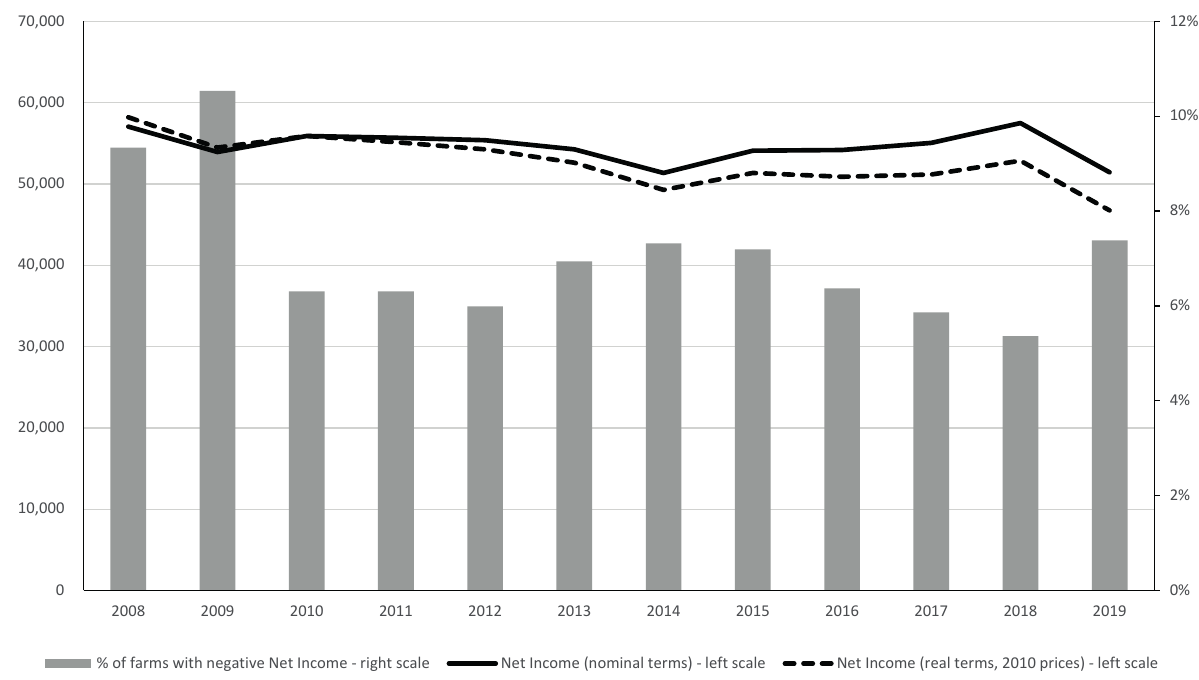
Figure 4.Average farm net income (€) over the 2008-2019 period within the Italian FADN balanced